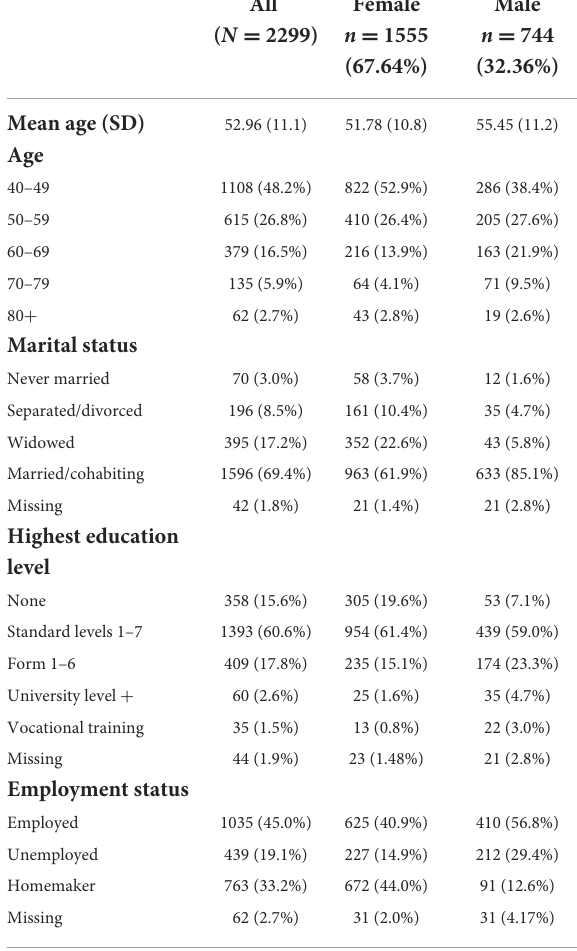
TABLE 1 Demographic characteristics of the HAALSI Tanzania cohort, stratified by